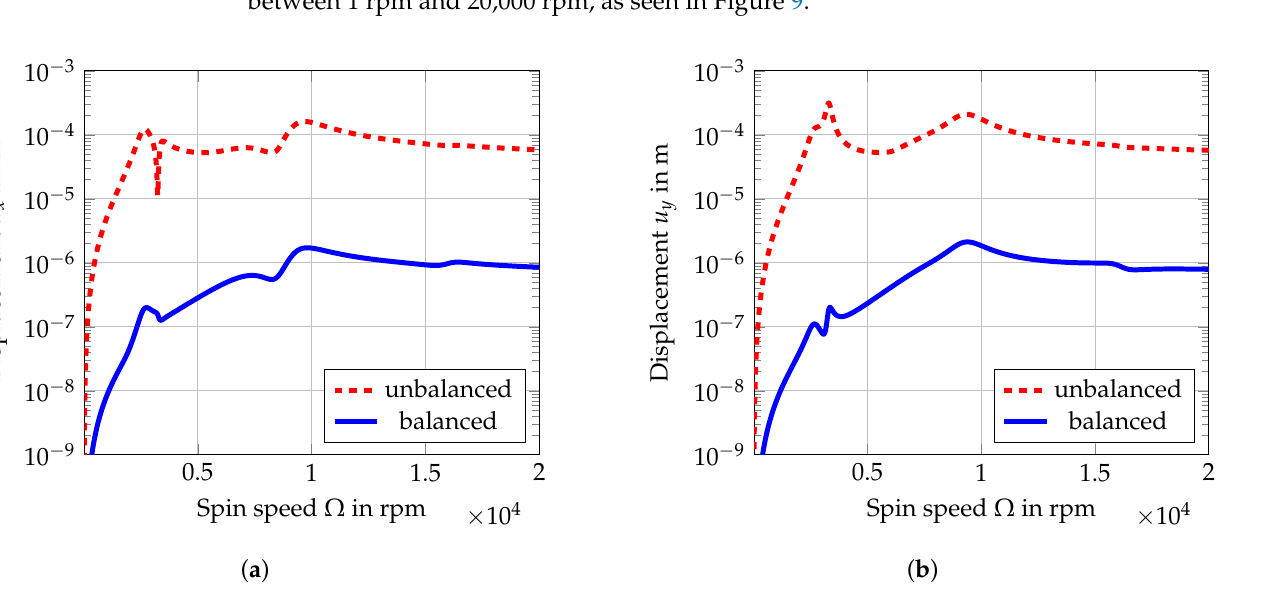
Figure 9. ( a ) Balancing success in x -direction and ( b ) balancing success in y